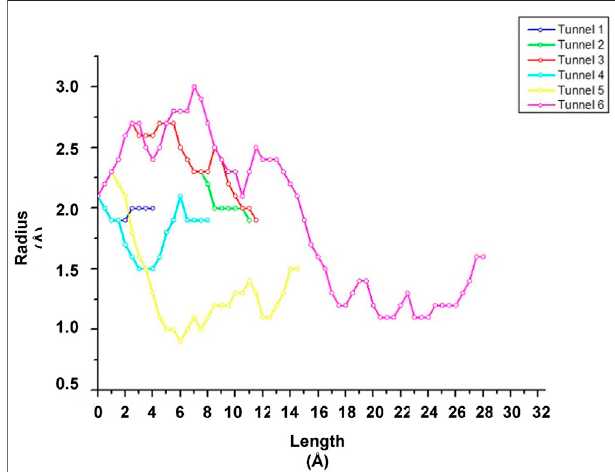
FIGURE 2 | Graphic representation of the length and radius of tunnels 1 (blue), 2 (green), 3 (red), 4 (light blue), 5 (yellow) and 6 (pink) present in the CALB